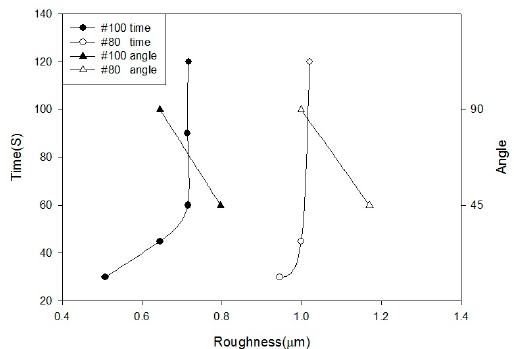
Figure 2. Relation between surface roughness and sandblasting pressure, distance.